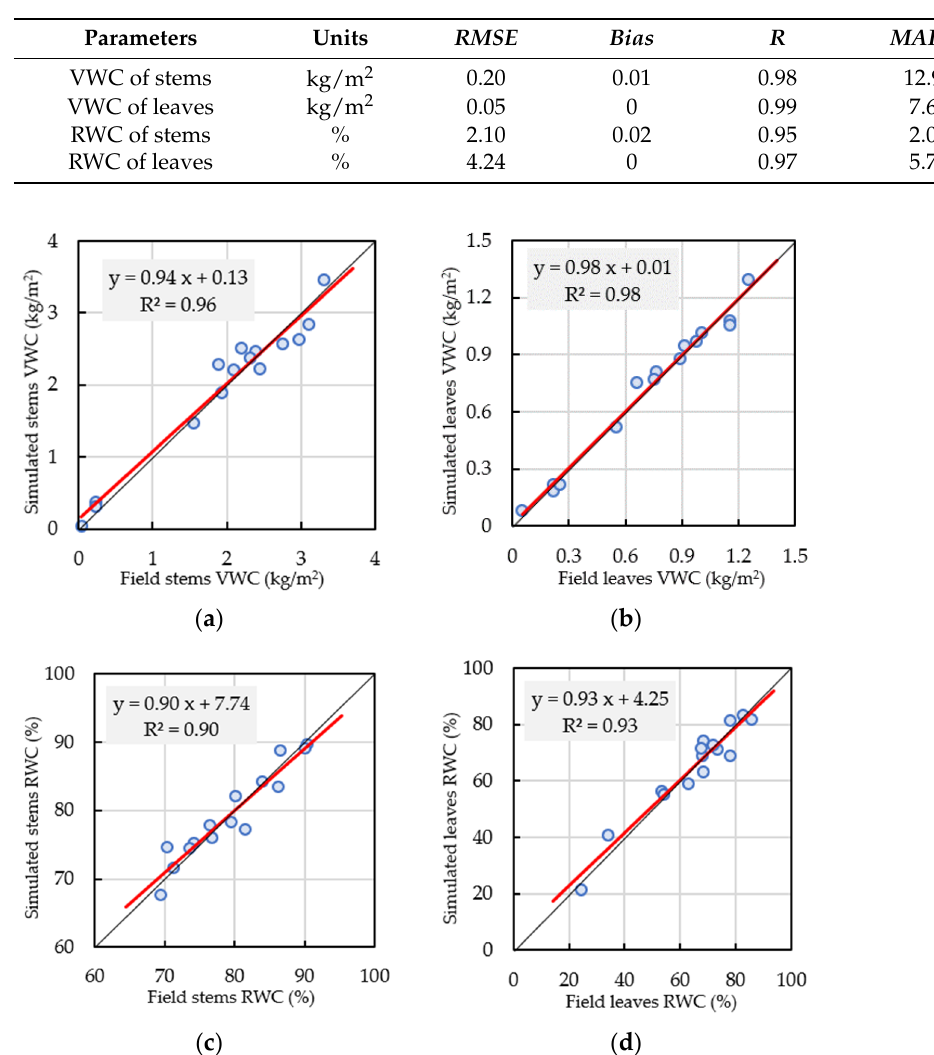
Table 5. The evaluation indicators of the simulated and field-measured values of the VWC and RWC in the maize stems and leaves.